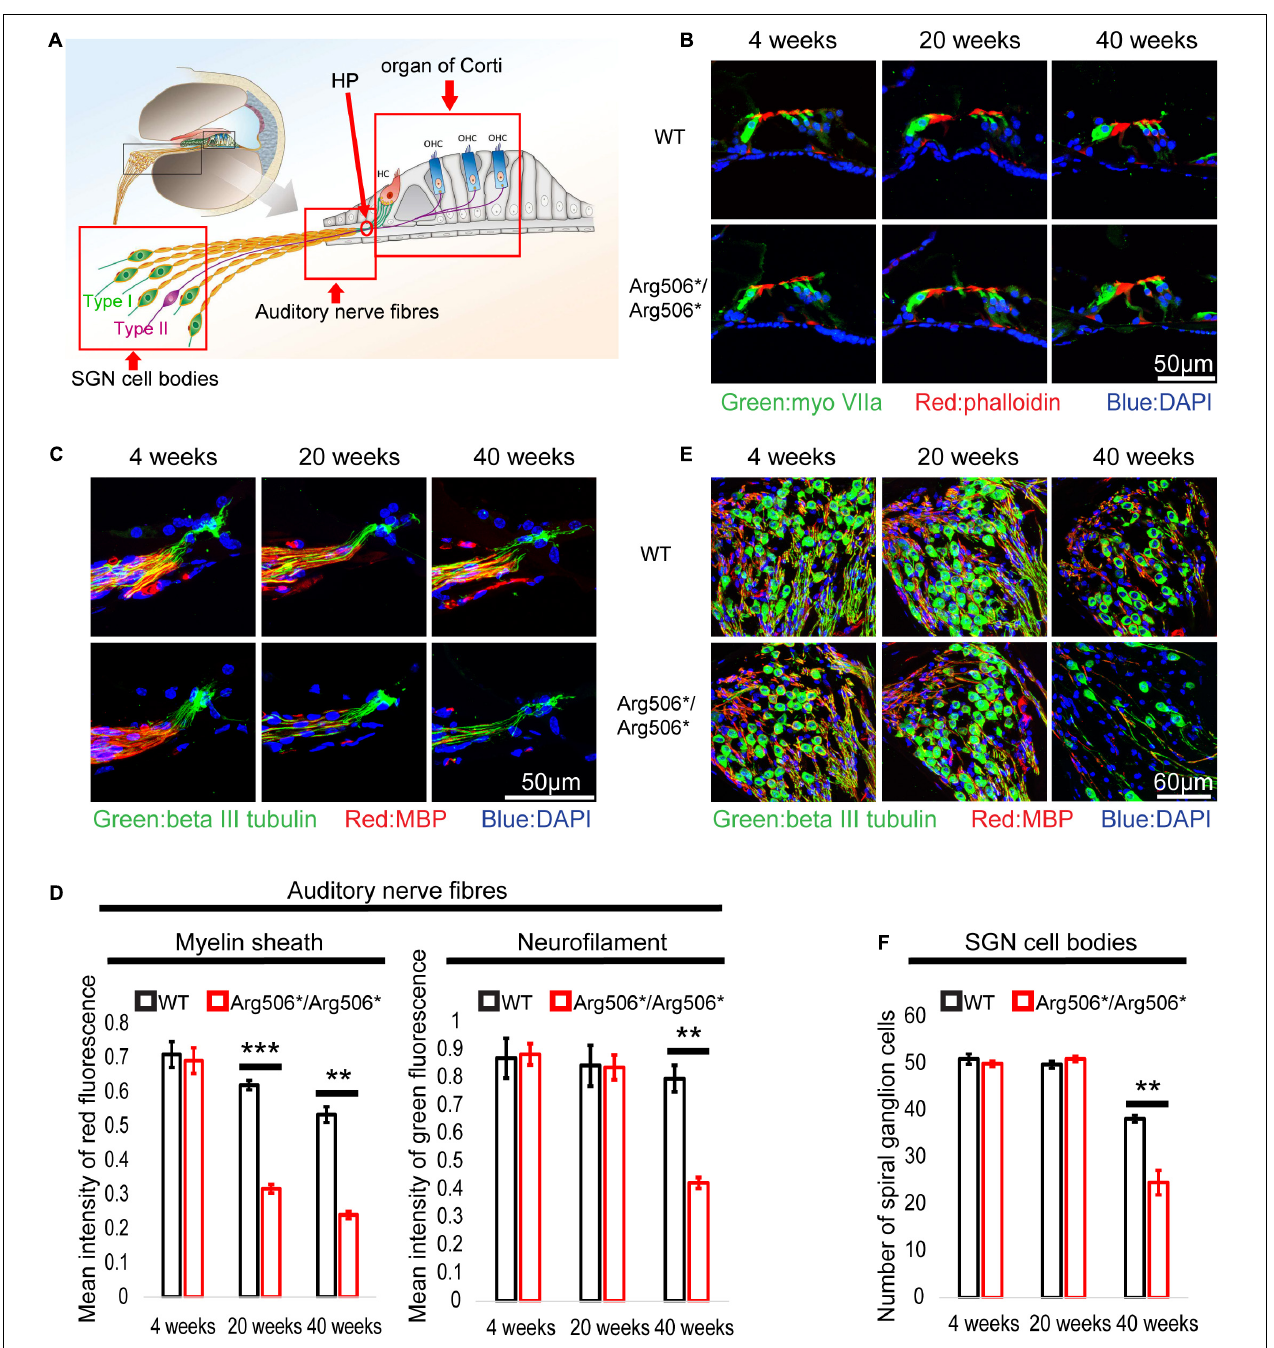
FIGURE 2 | Abnormal morphology in the cochlea of Atp6v1b2 Arg 506 ∗ / Arg 506 ∗ mice at different postnatal ages of 4, 20, and 40 weeks. (A) Illustration of the cochlear architecture. The three areas within the red frame (from left to right): spiral ganglion neuron (SGN) cell bodies, auditory nerve fibers, and organ of Corti. (B) There is no obvious difference in the morphology of organ of Corti between WT and Atp6v1b2 Arg 506 ∗ / Arg 506 ∗ mice. Phalloidin, MyoVIIa, and DAPI are markers of hair cell cilia, inner/outer hair cells, and nuclei, respectively. The experiments were repeated three times. (C) Representative images of auditory nerve fibers for WT and Atp6v1b2 Arg 506 ∗ / Arg 506 ∗ mice. (D) Statistical results of the red and green fluorescence intensities for panel (C) . The intensity of red fluorescence (myelin) decreased significantly at 20 and 40 weeks in Atp6v1b2 Arg 506 ∗ / Arg 506 ∗ mice. The intensity of green fluorescence (nerve fibers) decreased significantly at 40 weeks in Atp6v1b2 Arg 506 ∗ / Arg 506 ∗ mice. (E) Representative images of SGN cell bodies of WT and Atp6v1b2 Arg 506 ∗ / Arg 506 ∗ mice. (F) Statistical results of the number of SGN cell bodies for panel (E) . The number of SGN cell bodies decreased significantly in Atp6v1b2 Arg 506 ∗ / Arg 506 ∗ mice compared to that in WT mice at 40 weeks. The myelin sheath, nerve fibers, and nuclei are labeled with red (MBP), green (beta III tubulin), and blue (DAPI) fluorescence, respectively. The t -test was performed to evaluate the statistical significance. Each group included three mice, and one slice for each mouse was processed. ** denotes P < 0.01, *** denotes P < 0.001. Data are described as mean ± SEM (standard error of mean). HP, habenula perforate.